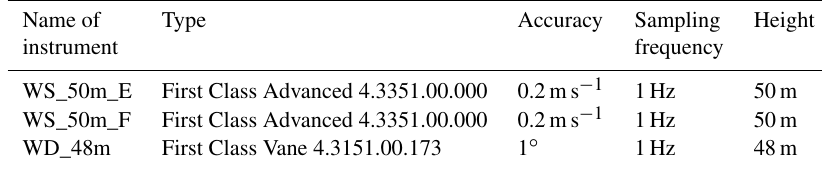
Table 3. Overview of the specifications of cup anemometers and wind vanes used for CDL validation.